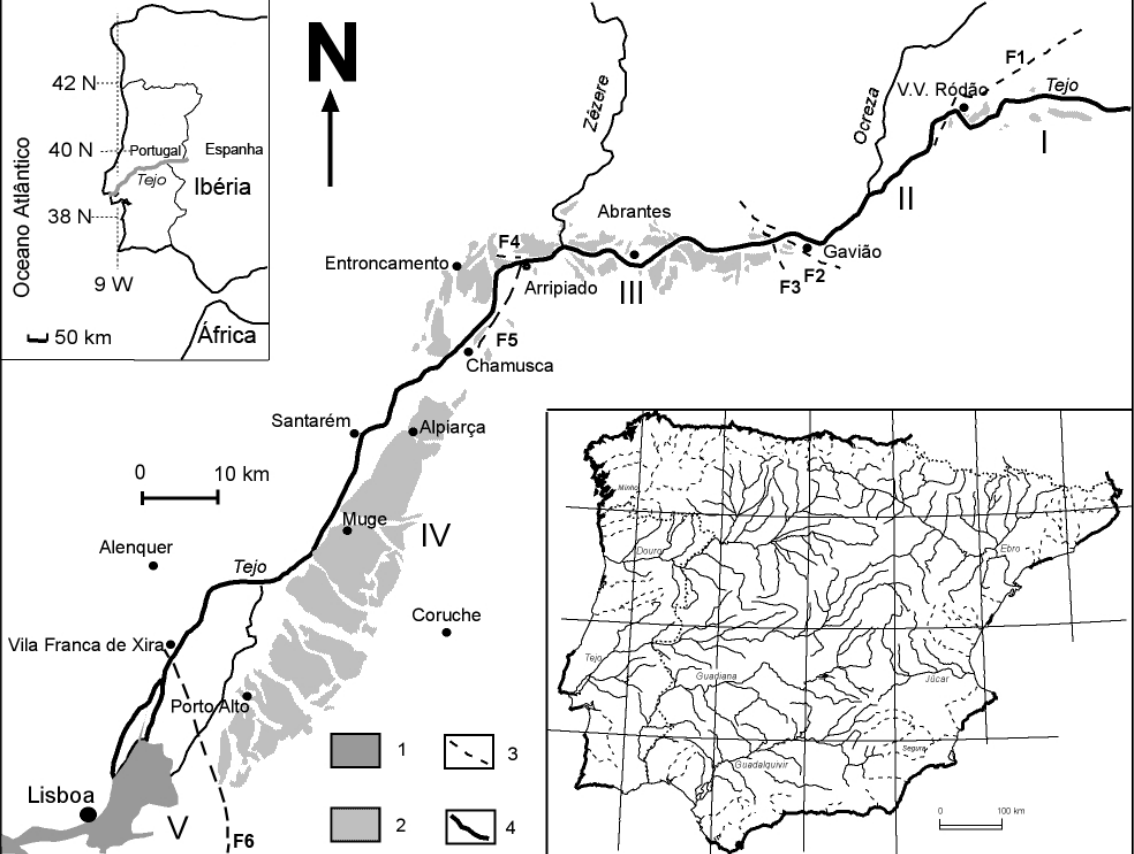
Figura 2. Principais troços do rio Tejo em Portugal (Bacia do Baixo Tejo): I - da fronteira ao Arneiro (depressões de Ródão e Arneiro; um traçado geral E-W constituído, principalmente, de segmentos poligonais); II - do Arneiro ao Gavião (NE-SW); III - do Gavião ao Arripiado (E-W); IV - do Arripiado a Vila Franca de Xira (NNE-SSW); V - de Vila Franca de Xira ao litoral Atlântico. Representam-se as falhas que delimitam os diferentes troços: F1 - falha do Ponsul-Arneiro (WSW-ENE); F2 - falha do Gavião (NW-SE); F3 - falha de Ortiga (NW-SE); F4 - falha de Vila Nova da Barquinha (W-E); F5 - falha do Arripiado-Chamusca (NNE-SSW); F6 - falhas do Pinhal Novo (N-S) -Vila Franca de Xira (NW-SE). 1 - estuário; 2 - terraços; 3 - falhas; 4 - canal principal do Tejo. A branco estão representadas as rochas ante-Plistocénico. No inset representam-se as principais redes de drenagem ibéricas. Figure 2. Main Portuguese reaches in which the Tejo River can be divided (Lower Tagus Basin): I - from the Spanish border to Arneiro (a general E-W trend, mainly consisting of polygonal segments); II - from Arneiro to Gavião (NE-SW); III - from Gavião to Arripiado (E-W); IV - from Arripiado to Vila Franca de Xira (NNE- SSW); V - from Vila Franca de Xira to the Atlantic shoreline. The faults considered to be the limit of the referred fluvial reaches are represented: F1 - Ponsul-Arneiro fault (WSW-ENE); F2 - Gavião fault (NW-SE); F3 - Ortiga fault (NW-SE); F4 - Vila Nova da Barquinha fault (W-E); F5 - Arripiado-Chamusca fault (NNE-SSW); F6 - Pinhal Novo fault (N-S) -Vila Franca de Xira fault (NW-SE). 1 - estuary; 2 - terraces; 3 - faults; 4 - Tagus main channel. In white is represented the pre-Pleistocene rocks. The inset shows the main Iberian drainage